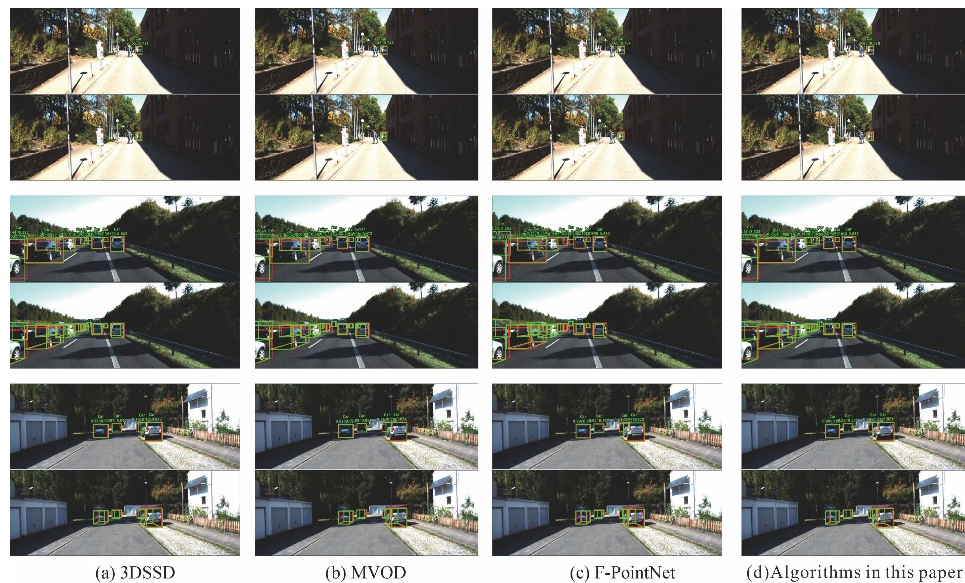
Figure 16. Algorithm effect comparison diagram.